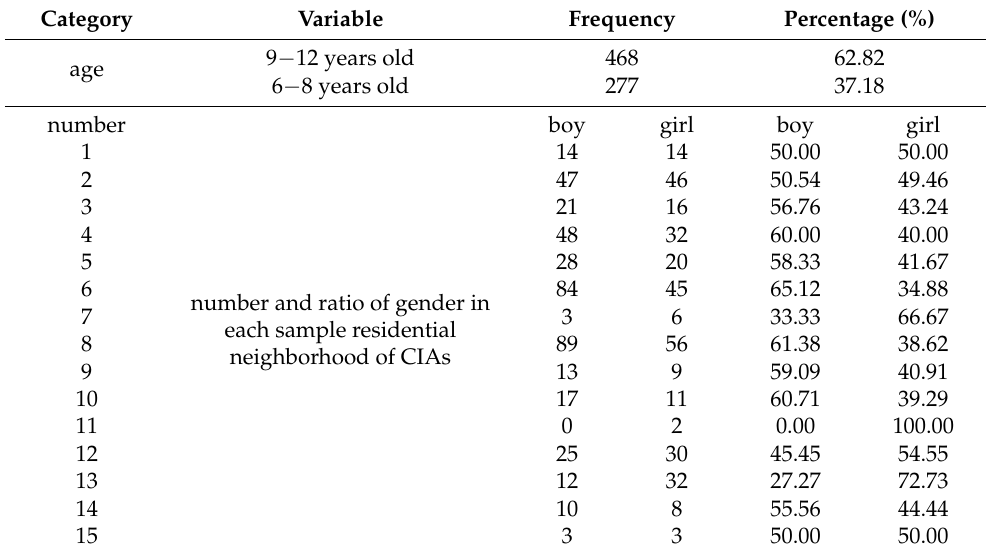
Table 4. Statistics on the age and gender differences of CIAs in sample neighborhoods.